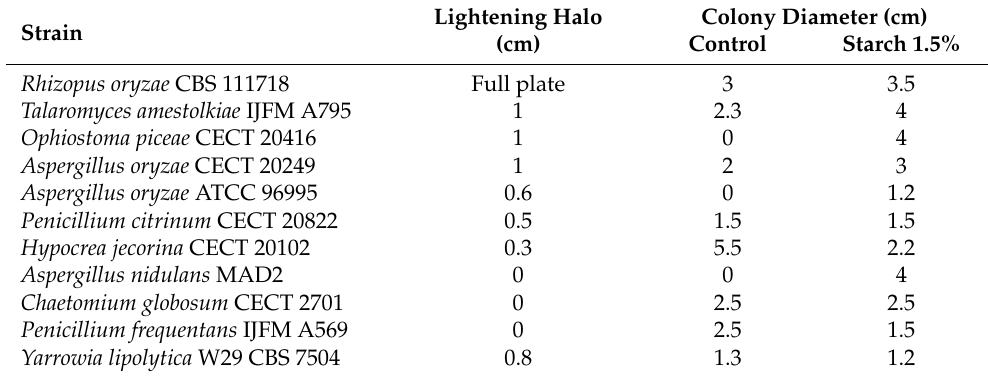
Table 1. Screening of starch degradation by selected fungal